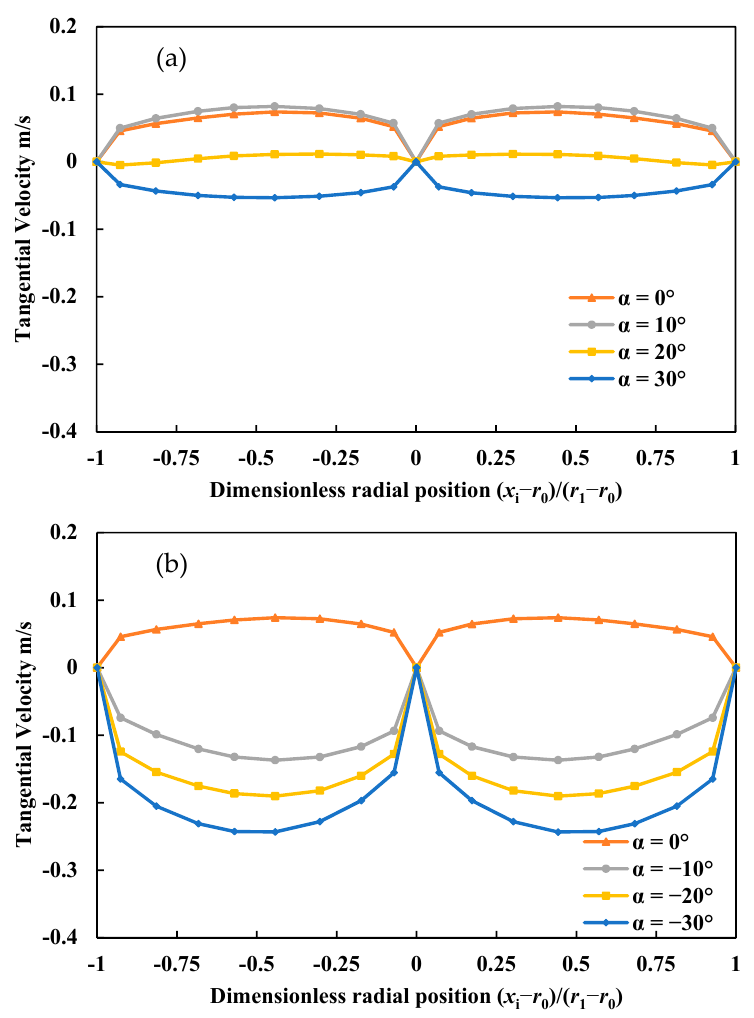
Figure 16. Dimensionless radial profiles of tangential velocity with different helical angles for V-shaped blade at z = 1.0m cross section: ( a ) positive blade and ( b ) negative blade.